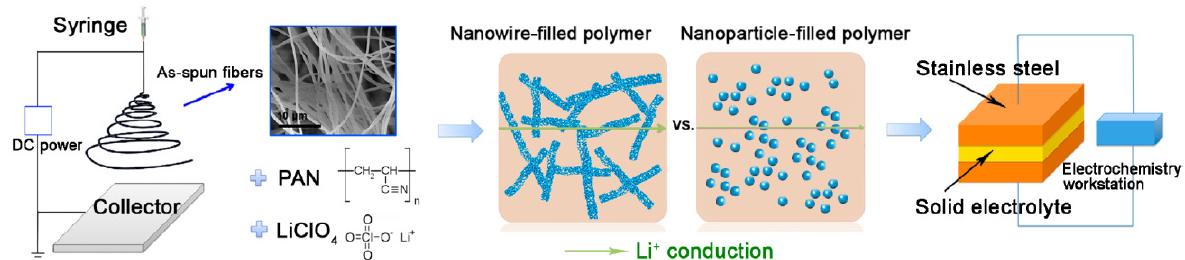
Figure 4. Schematic illustration of the synthesis of ceramic nanowire-filled polymer-based composite electrolytes, together with the comparison of possible lithium-ion conduction pathway in nanowire-filled and nanoparticle-filled composite electrolytes, and illustration of the electrode. Reprinted with permission from [174]. Copyright (2015) American Chemical Society.